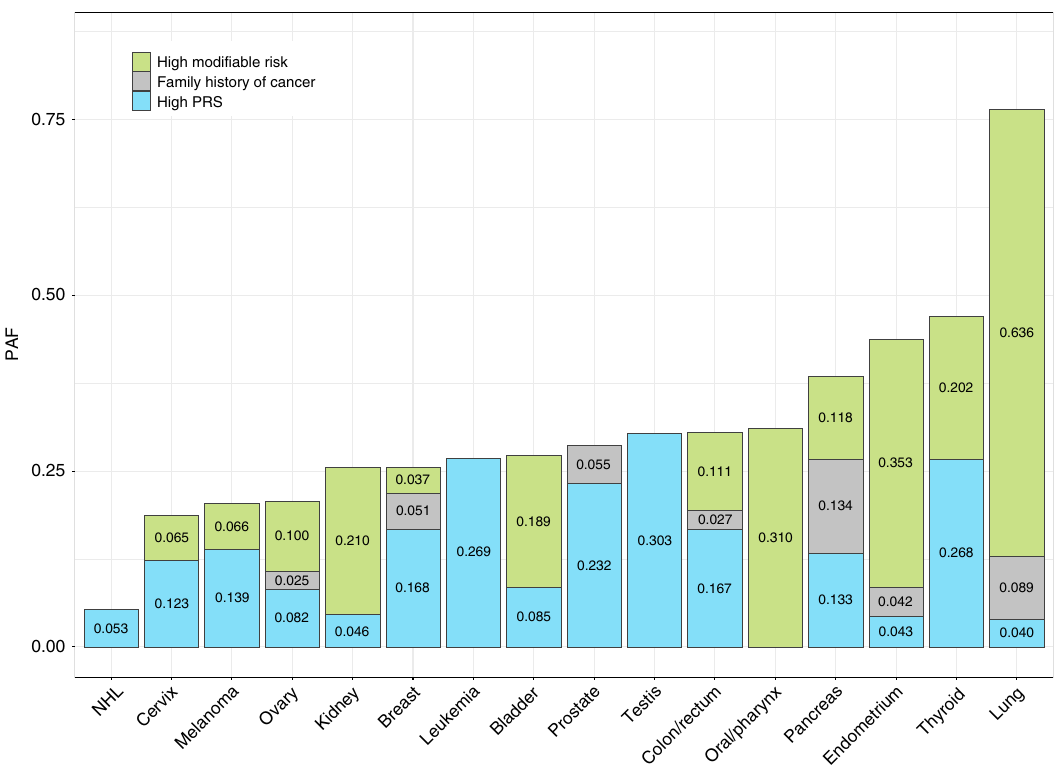
Fig. 6 Population attributable fractions (PAF) estimated at 5 years of follow-up time. PAF estimates for the top 20% ( ≥ 80th percentile) of the modi fi able risk factor and polygenic risk score (PRS) distributions, respectively, and family history of cancer, were derived from Cox proportional hazard regression models adjusted for age at enrollment, sex, genotyping array, and the top 15 genetic ancestry principal